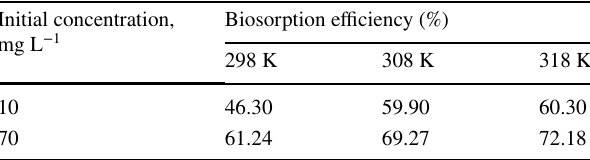
Table 1 Biosorption efficiencies at the studied lowest and highest ini- tial concentrations of MB at various temperatures Initial concentration, mg L